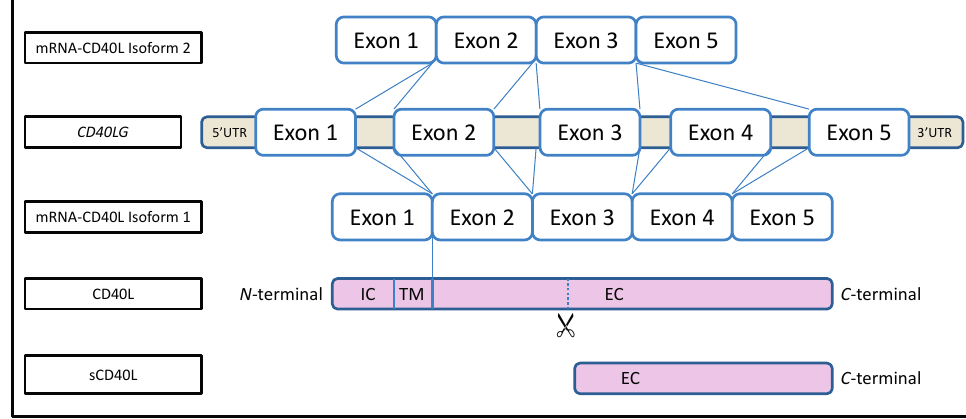
Figure 1. Sheme of the CD40 ligand gene structure and its different